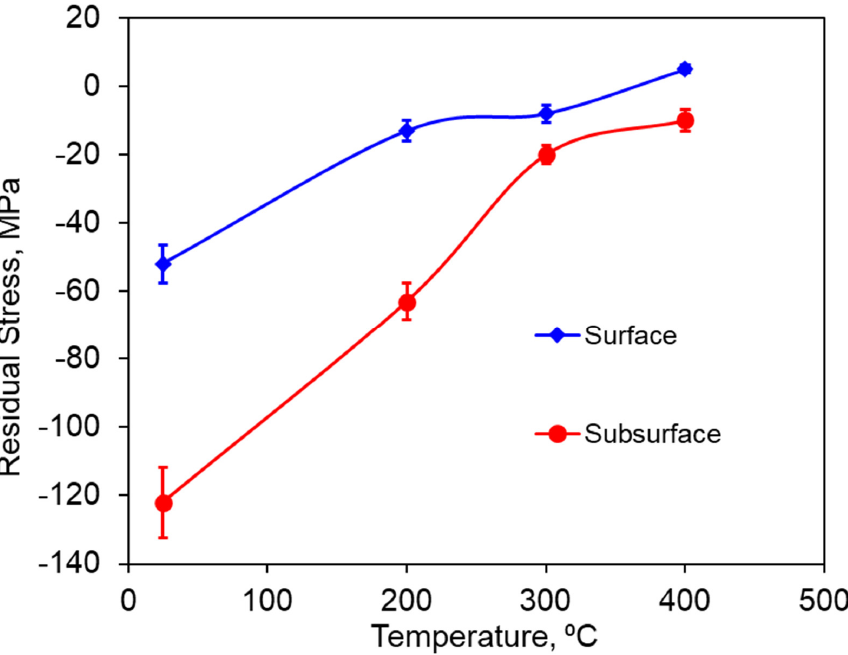
Figure 4. Residual stress distribution in the coating surface and subsurface measured by XRD showing compressive to tensile residual stress due to heat treatment.